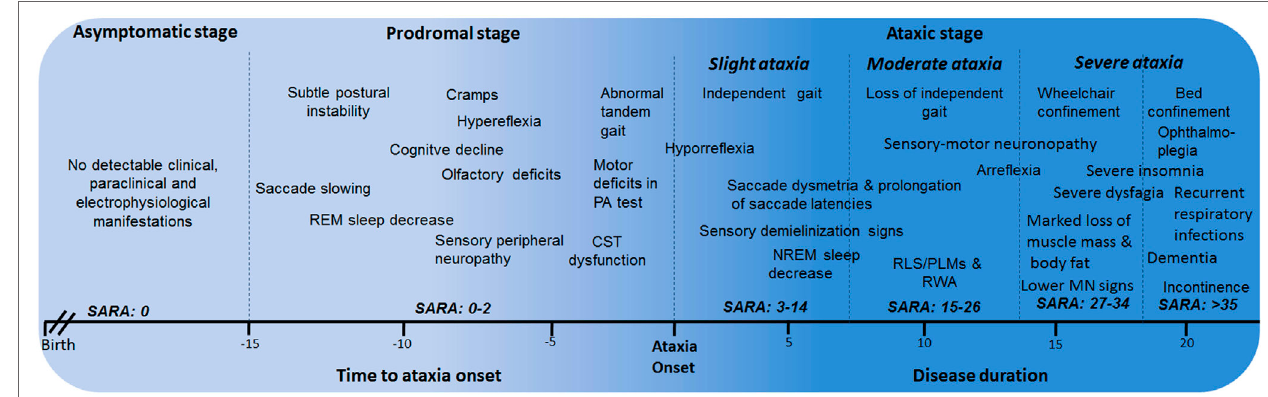
FiGURe 2 | Stages of spinocerebellar ataxia type 2 (SCA2) progression. CST, corticospinal tract; PA, prism adaptation; REM, rapid eye movement; RLS, restless legs syndrome; PLMS, periodic leg movements syndrome; MN, motor neuron; RWA, REM sleep without